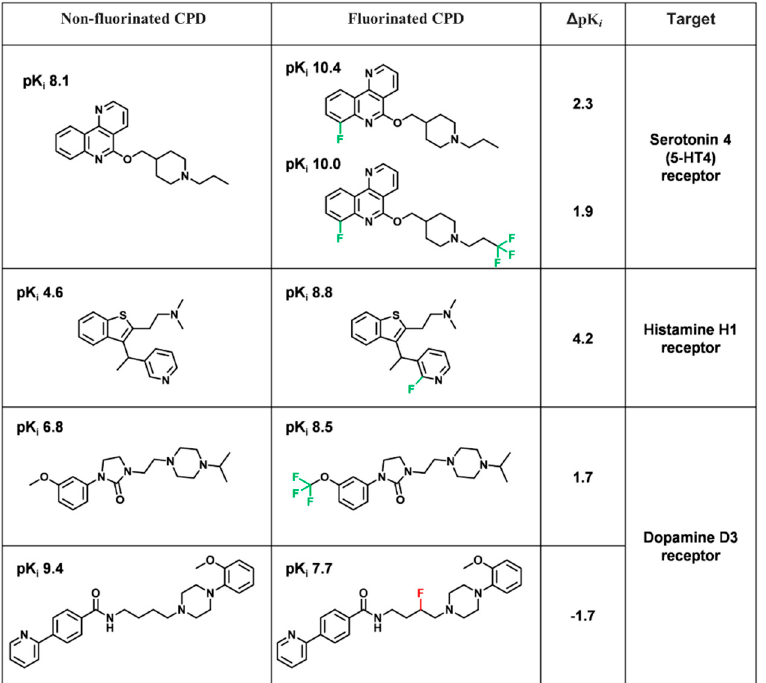
Figure 4. Exemplary activity cliffs. Five exemplary ACs resulting from compound fluorination are shown. For each non-F (left)–fluorinated (middle) compound pair, the ∆ pPot (i.e., ∆ pK i ) value, and the corresponding target name are reported on the right. In addition, potency values for each compound are